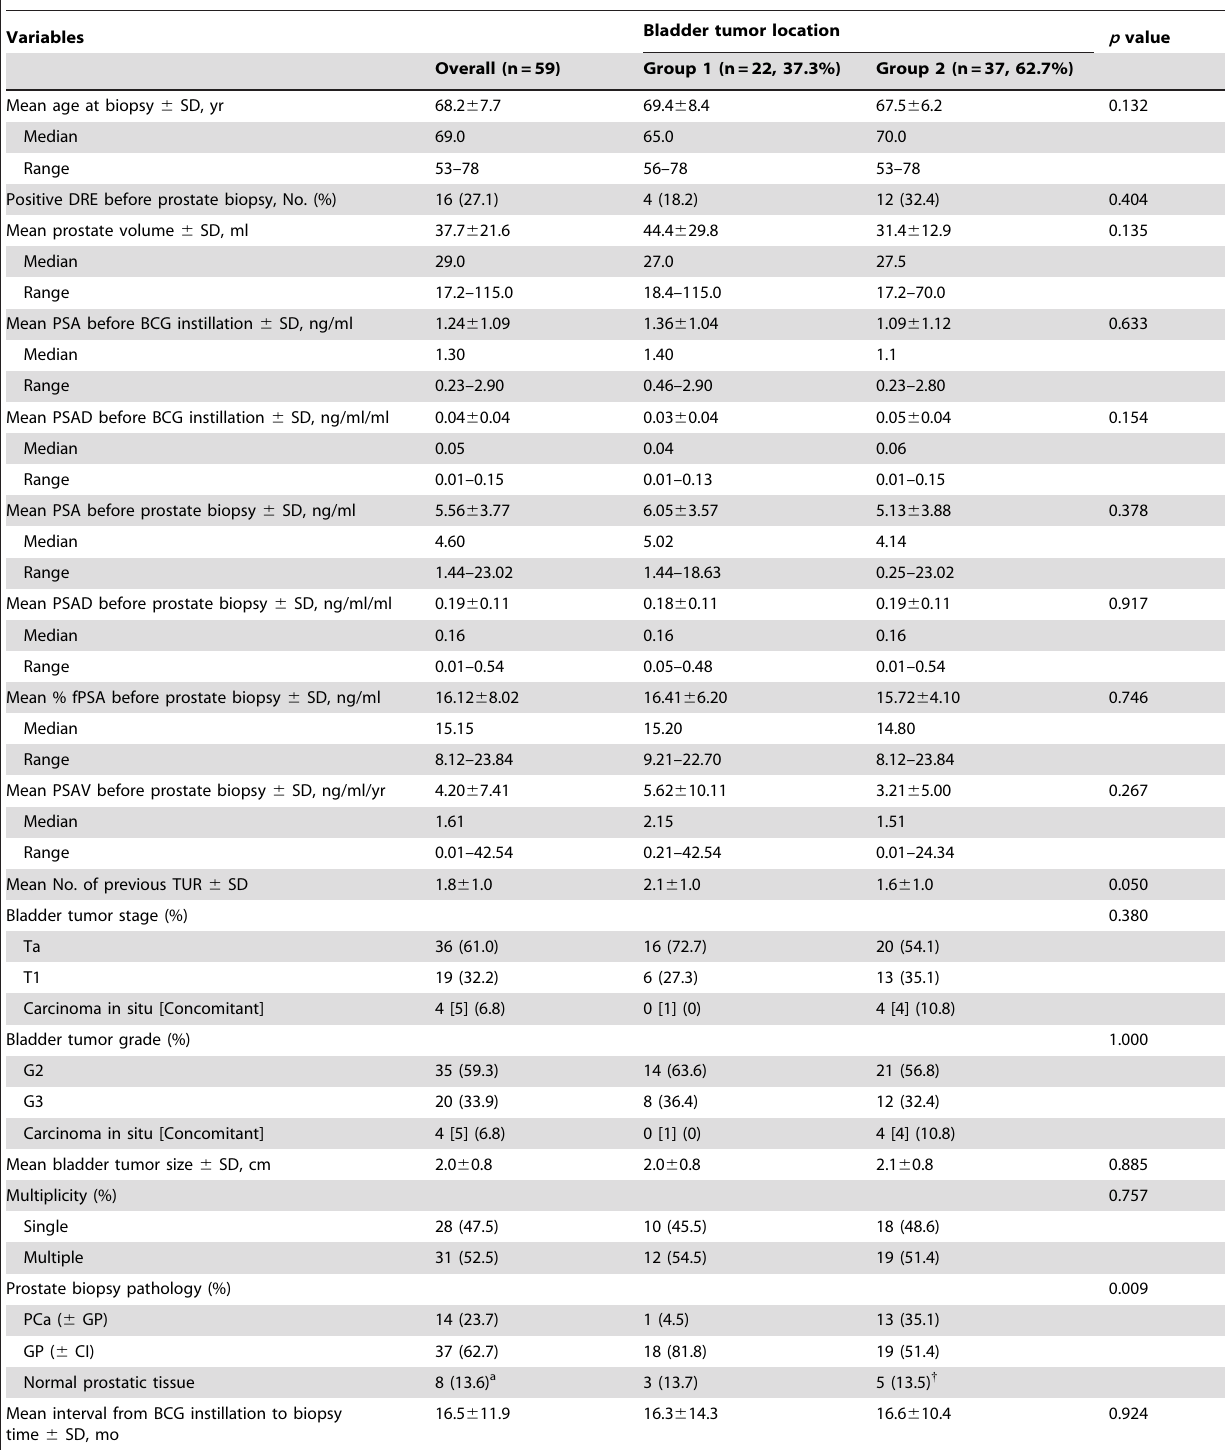
Table 1. Patient Characteristics of According to the Bladder Tumor